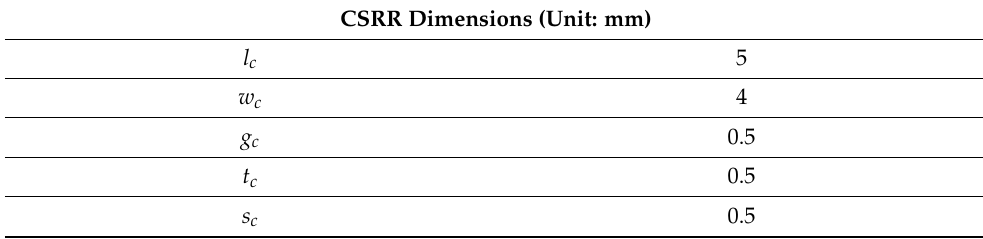
Figure 4. S-Parameter response of proposed antenna by varying the dimensions ( g c ) of CSRR unit-cell which has fixed value of 0.5 mm for t c and s c . Table 1. CSRR Unit-cell Dimensions.